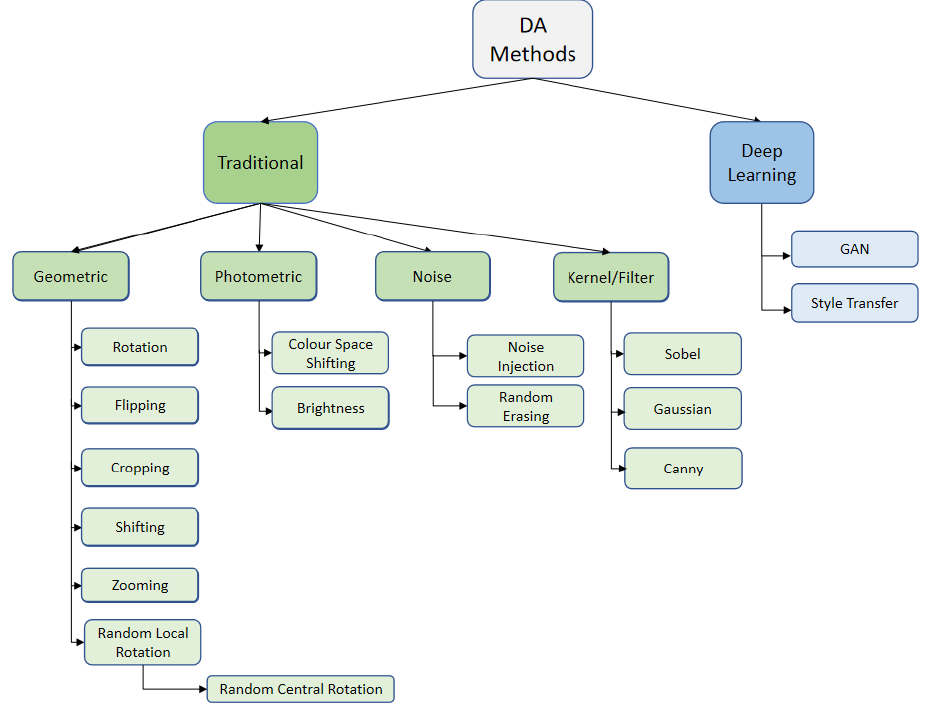
Figure 3. Data augmentation (DA)